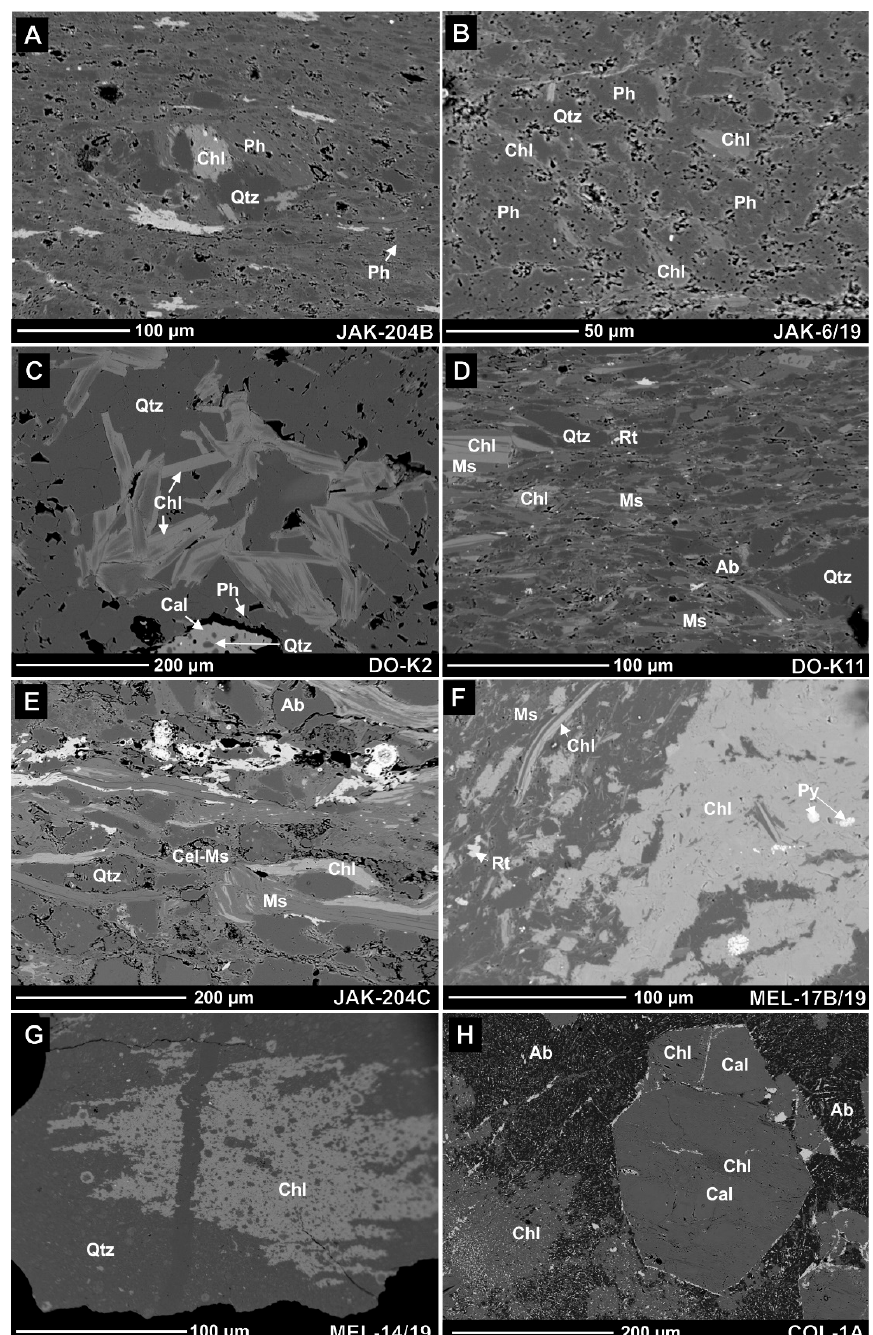
Figure 20. BSE images from the Jaklovce Unit metaradiolarites ( A – C ), Meliata Unit flysch ( D – F ) and radiolarite ( G ) and Č oltovo metabasalt ( H ): ( A – C ) Ph–Chl metaradiolarite associated with Jaklovce Unit metabasalts; ( D ) sandy layer in siliciclastic flysch composed of clastogenic Ms, Chl and Qtz and newly formed Ab in the Kon č istá area south of Dobšiná; ( E ) sandy layer in the siliciclastic flysch composed of clastogenic Ms and Qtz and newly formed Chl, Cel–Ms and Ab at Jaklovce; ( F ) contact of dark red radiolarite layer with siliciclastic flysch at Meliata. Porphyroclasts of Ms (to illite–phengite) and Chl are bent in a cherty matrix overgrown by newly formed Chl porphyroblast; ( G ) dark metaradiolarite layer in cherty flysch with newly formed Chl porphyroblast at Meliata; ( H ) Č oltovo metabasalt with porphyric Cpx replaced by Chl and Cal. Plagioclase is Ab.